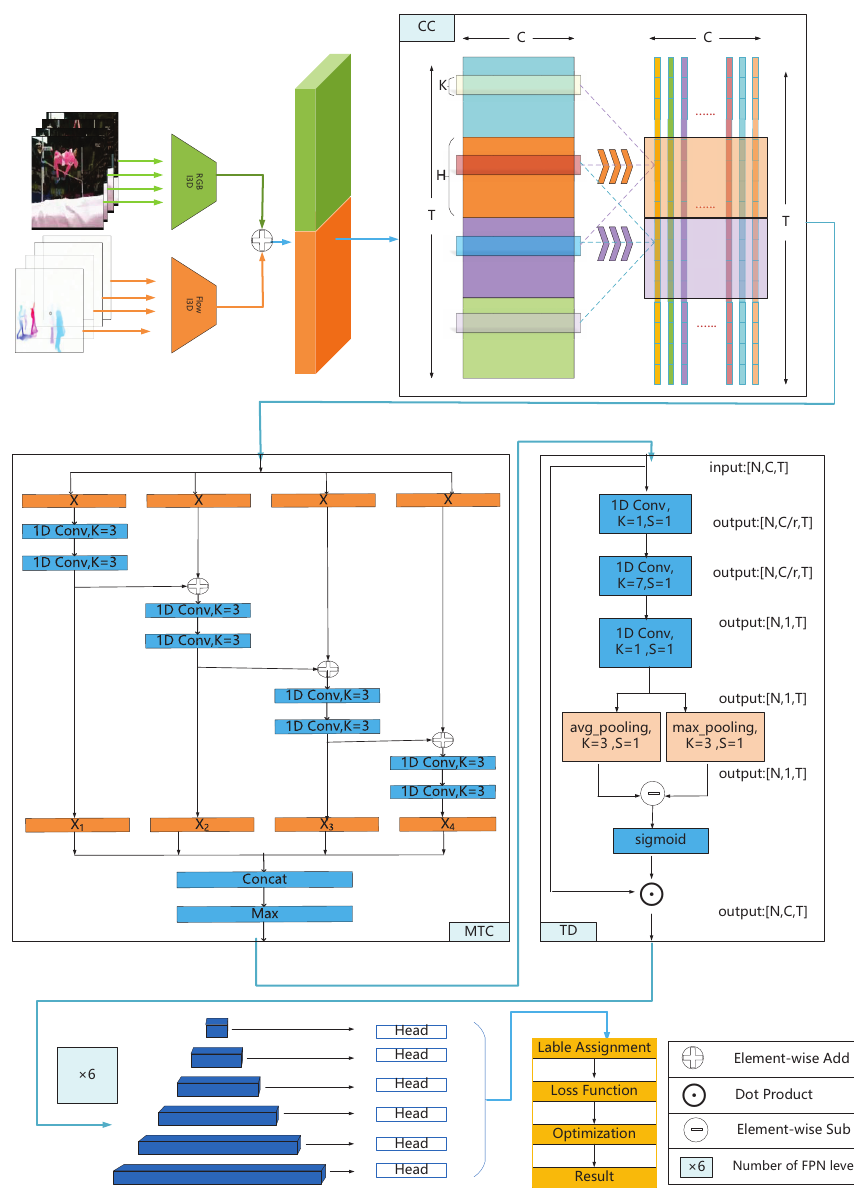
Figure 1. Overview of our proposed NTD. NTD first transforms the raw video into a sequence of clip features. Then, the clip features sequentially go through three modules. CC module, delivering information over long distances. MTC module, aggregating multiscale temporal features. TD module, adaptively enhancing motion information and boundary features. Finally, the encoded features pass through the temporal feature pyramid module, and the prediction head is responsible for generating detection